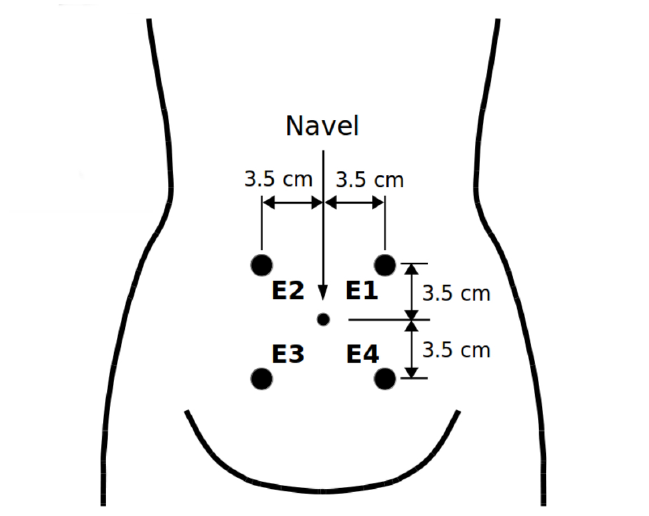
Figure 1. Positions of electrodes. The electrodes were placed symmetrically at a distance of 7 cm in two horizontal rows, above and under the navel